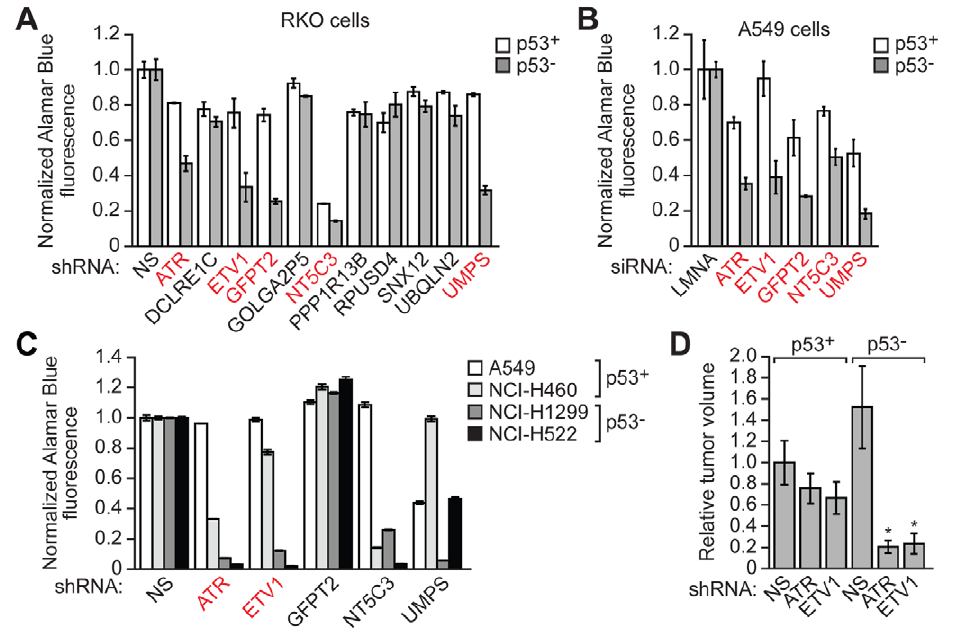
Figure 2. ETV1 and ATR are preferentially required for proliferation of diverse p53 2 cell lines. (A) Proliferation of p53 + and p53 2 RKO cells expressing an individual candidate shRNA, or as a control a NS shRNA, was determined by an Alamar Blue fluorescence assay. The results were normalized to that obtained with the NS shRNA, which was set to 1. Error bars represent SD. ShRNAs that preferentially affect the proliferation of p53 2 relative to p53 + cell lines are indicated in red. (B) Proliferation of p53 + and p53 2 A549 cells transfected with a candidate siRNA, or as a control a LMNA siRNA, was determined by an Alamar Blue fluorescence assay. The results were normalized to that obtained with the LMNA siRNA, which was set to 1. Error bars represent SD. ShRNAs that preferentially affect the proliferation of p53 2 relative to p53 + cell lines are indicated in red. (C) Proliferation of A549, NCI-H460, NCI-H1299 and NCI-H522 cells expressing a candidate shRNA, or as a control an NS shRNA, was determined by an Alamar Blue fluorescence assay. The results were normalized to that obtained with the NS shRNA, which was set to 1. Error bars represent SD. ShRNAs that preferentially affect the proliferation of p53 2 relative to p53 + cell lines are indicated in red. (D) p53 + and p53 2 HCT116 cells expressing an ATR or ETV1 shRNAs or as a control a NS shRNA, were subcutaneously injected into opposite flanks of the same nude mouse, and tumor volume was measured after 4 weeks. The results were normalized to that obtained in p53 + cells expressing a NS shRNA, which was set to 1. Error bars represent SD. * P #